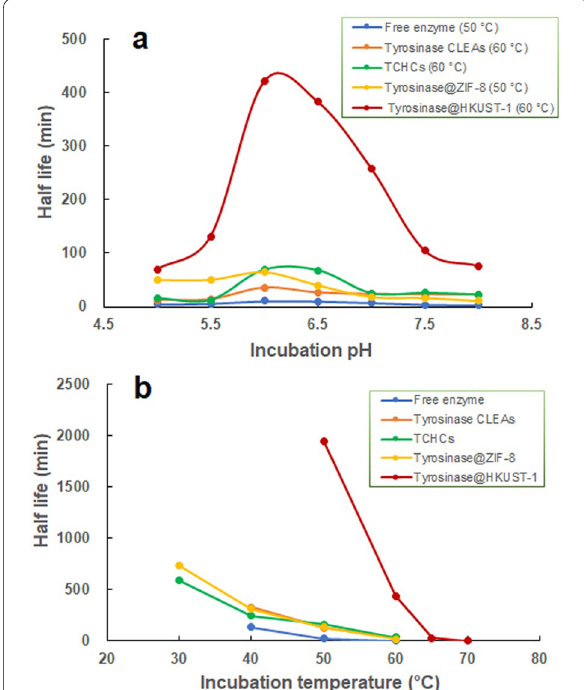
Fig. 2 A comparison of the stability of tyrosinase@HKUST‑1 against pH ( a ) and temperature ( b ) with that of the free enzyme and its other three immobilization forms